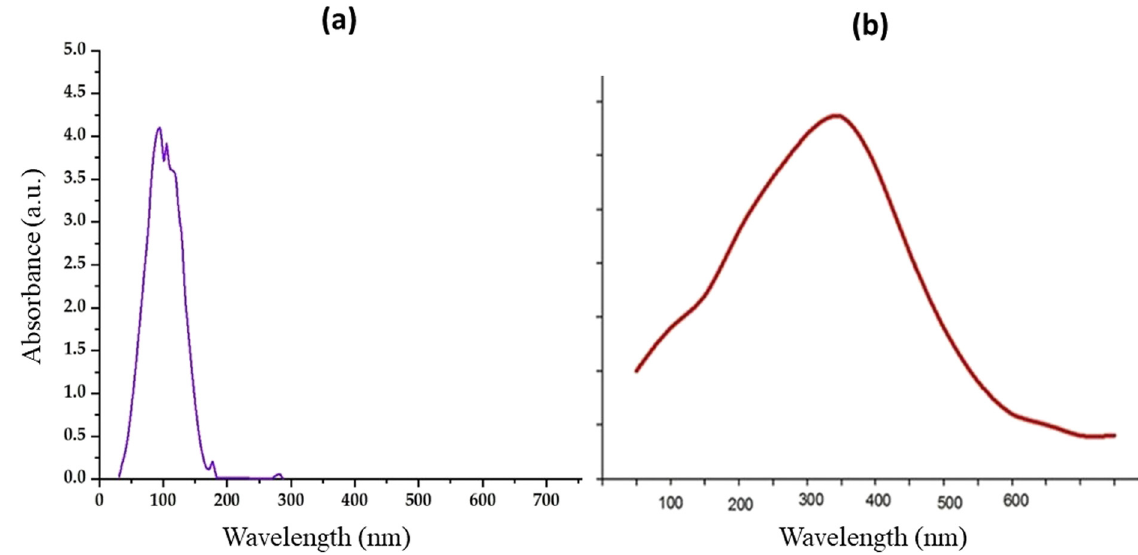
Figure 1: UV - Vis spectrum of ( a ) pumpkin seed extract and ( b ) biogenic CuO